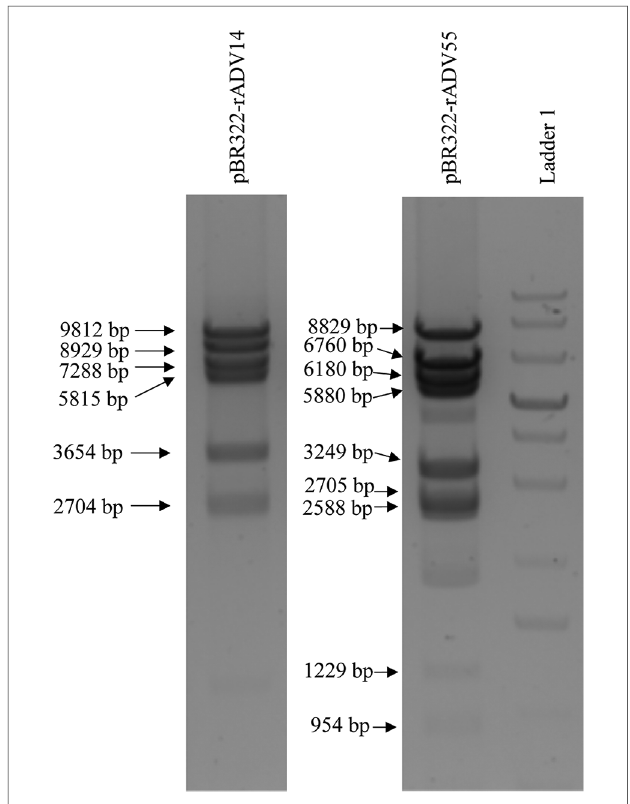
FIGURE 3 Restriction enzyme analysis of the pBR322-rAdV14 and pBR322-rAdV55 constructs. Analysis of the vector was performed by digesting 2.5 ug of the pBR322-rAdV14 DNA with the restriction enzymes EcoRI, NheI and ClaI. This digestion analysis resulted in 6 segments with sizes of 9,812, 8,929, 7,288, 5,815, 3,654 and 2,704 bp. The restriction pattern of the pBR322-rAdV55 when digested with NheI, PmeI, XbaI and ClaI resulted in shows 9 segments with sizes of 8,829, 7,660, 6,180, 5,880, 3,249, 2,705, 2,588, 1,229 and 954 bp. These patterns correspond to those expected for correct constructs. Ladder 1 is a GeneRuler 1 kb Plus DNA Ladder (Thermo Scienti fi c, Cat#: